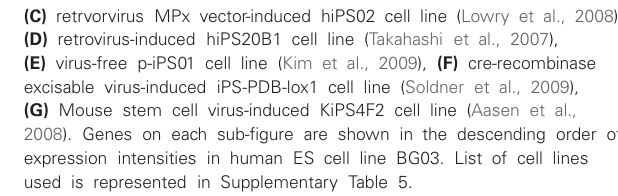
FIGURE 1 | Logarithm of fold change (FC) comparison of gene expression profiles between representative iPS cell from each of 7 experiments and respective ES cell (blue) and two ES cell lines H13B and H9 obtained from GEO platform 570 (red). Eight experiments had less number of shared genes (6357) (not shown). In total 9961 genes (15,758 probes) shared among 7 cell lines are shown. (A) retorvirus-induced iPS3_2 cell line (Masaki et al., 2008), (B) lentivirus-induced BJiPS12 cell line (Maherali et al., 2008),